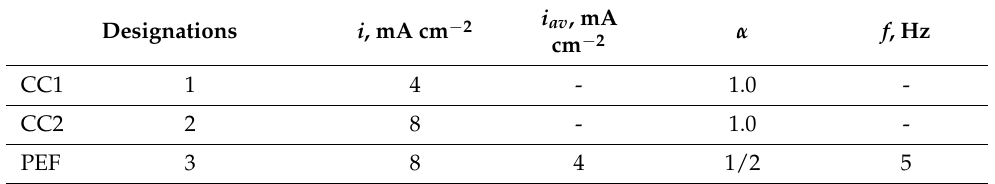
Table 5. Parameters of the current modes during ED desalination of the multicomponent solution.